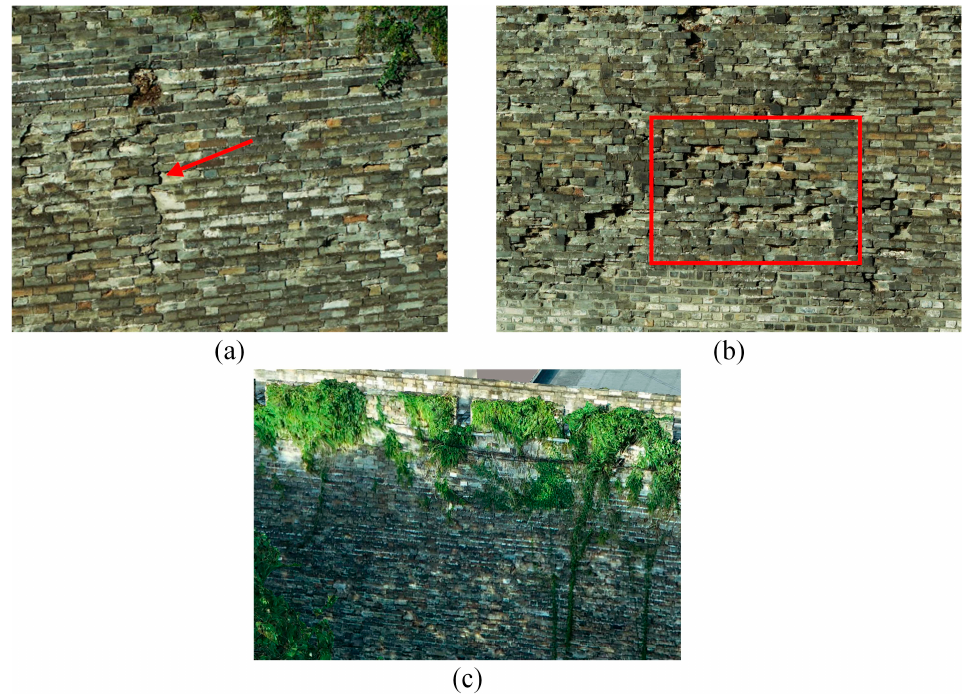
Figure 16. Various defects in 3D model of the city wall: ( a ) cracks; ( b ) wall shedding; ( c ) damage by vegetation growth.